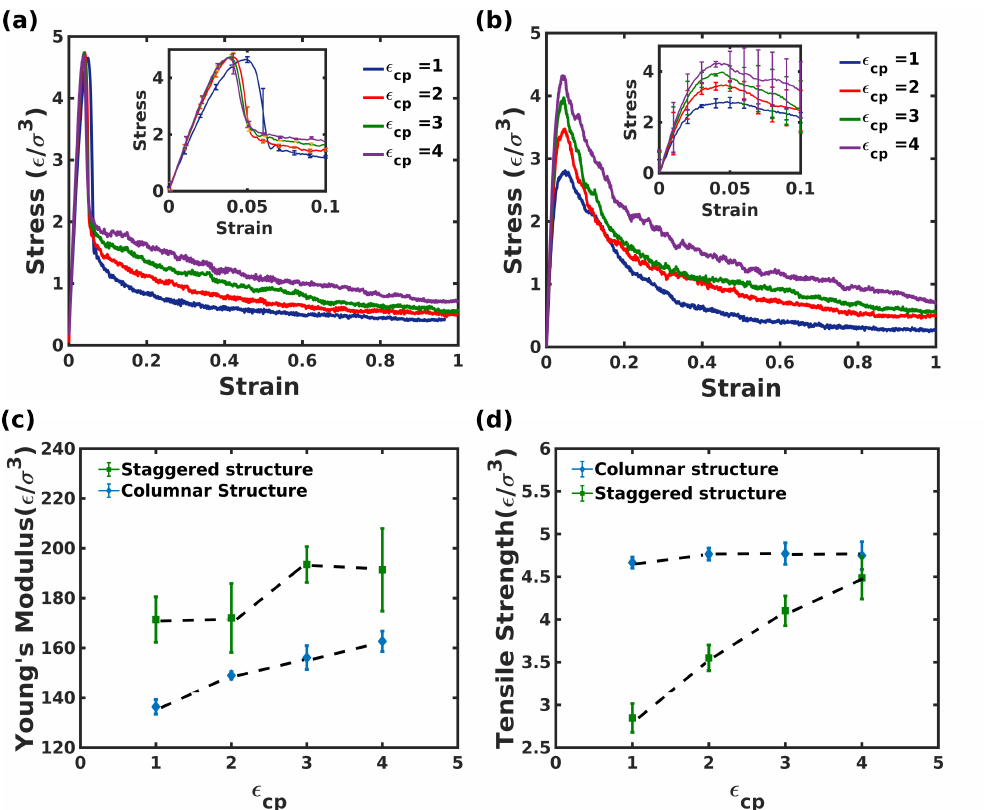
Figure 4. Stress-strain response ( a ) columnar structure for different polymer-crystal interactions ( (cid:101) cp ) , ( b ) staggered composite for different ( (cid:101) cp ) , ( c ) Young’s modulus for columnar and staggered structure and ( d ) Tensile strength for columnar and staggered composite for different ( (cid:101) cp ) . The plot contains the standard deviation calculated during tensile deformation along the X, Y, and Z axes. Dotted lines are guidelines for